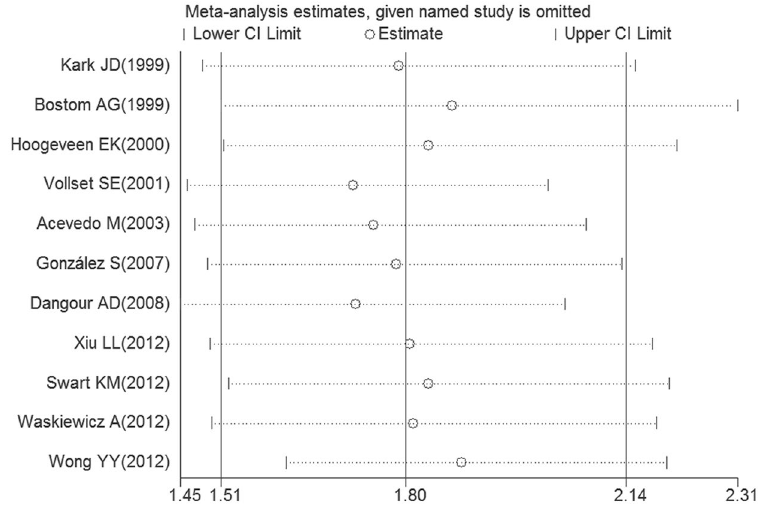
Figure 5. The plot of result of sensitivity